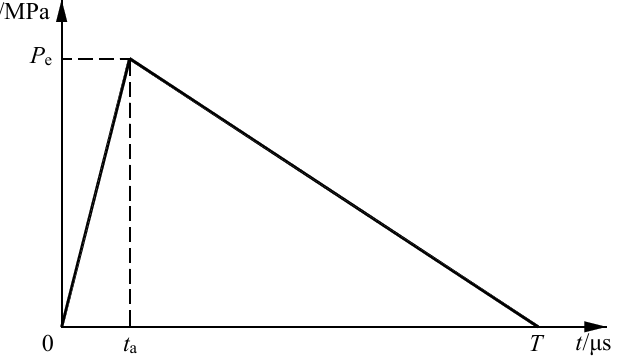
Figure 5. Time history of blast pressure described by triangular pattern.